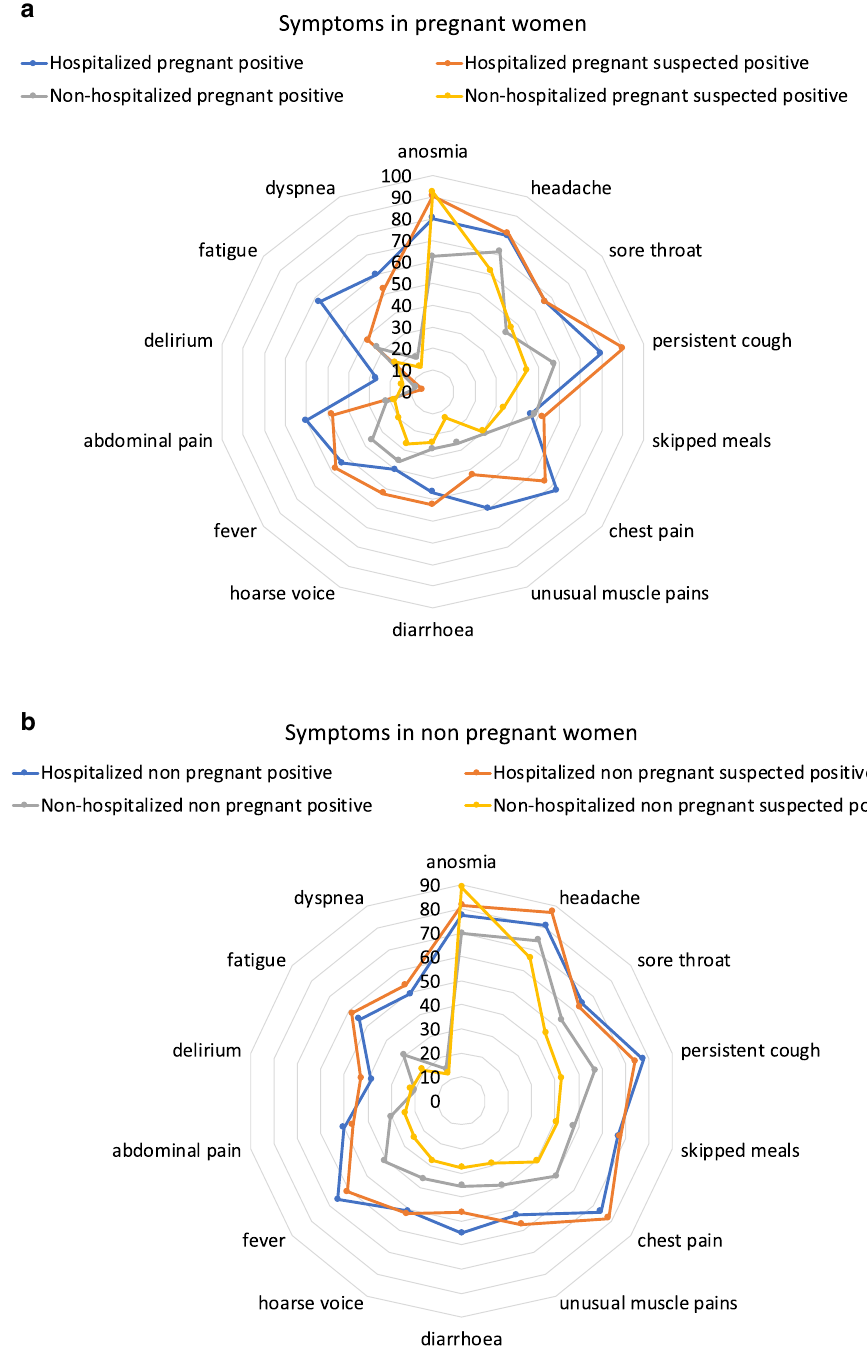
Figure 3. Symptom profile of hospitalized and non-hospitalized pregnant ( a ) and non-pregnant ( b ) women positive and suspected positive to SARS-CoV-2 in the discovery cohort. Results are reported in percentage of women reporting each symptom in each